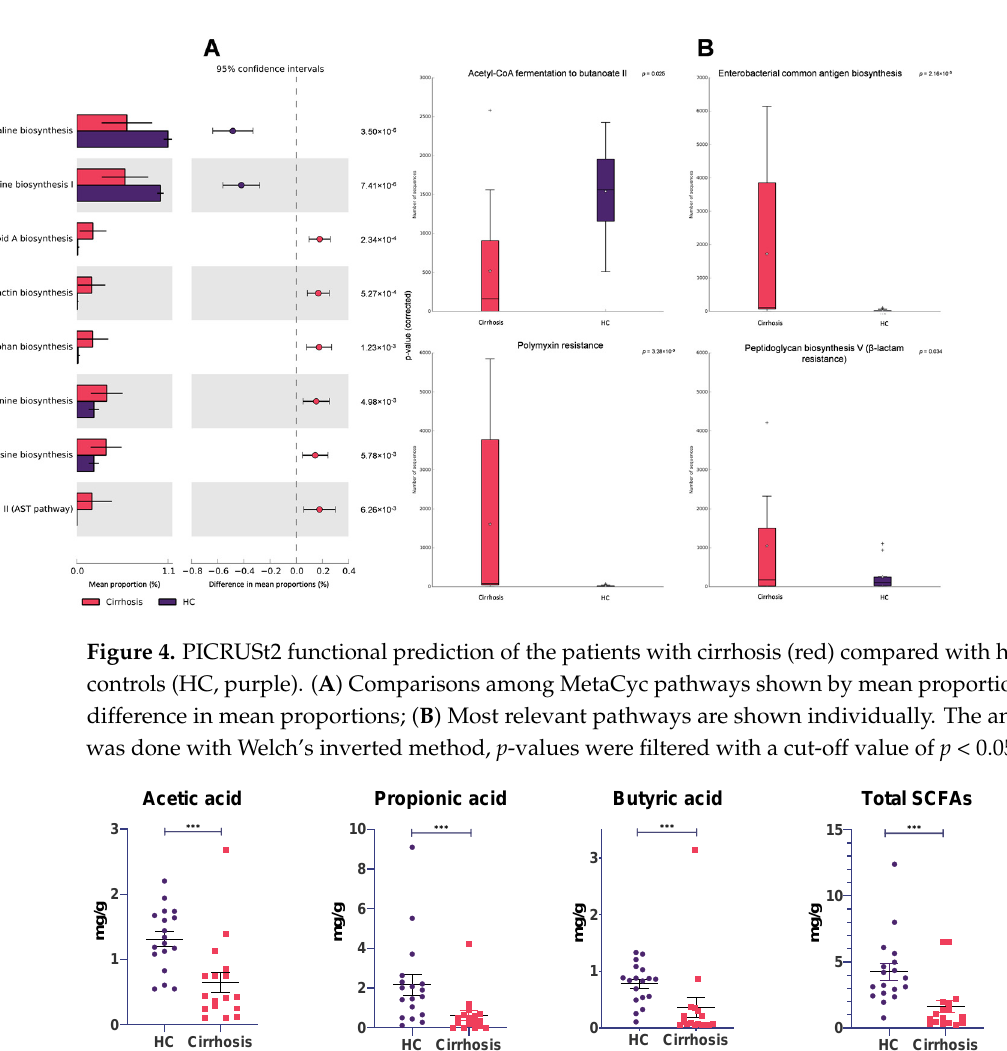
Figure 5. Short-chain fatty acids assessment in healthy controls (HC) and cirrhotic patients. The figure shows separate concentrations of acetic, propionic, butyric acids and total SCFAs. Results are expressed as mean ± SEM. Analyzed by Mann-Whitney U test, *** p <